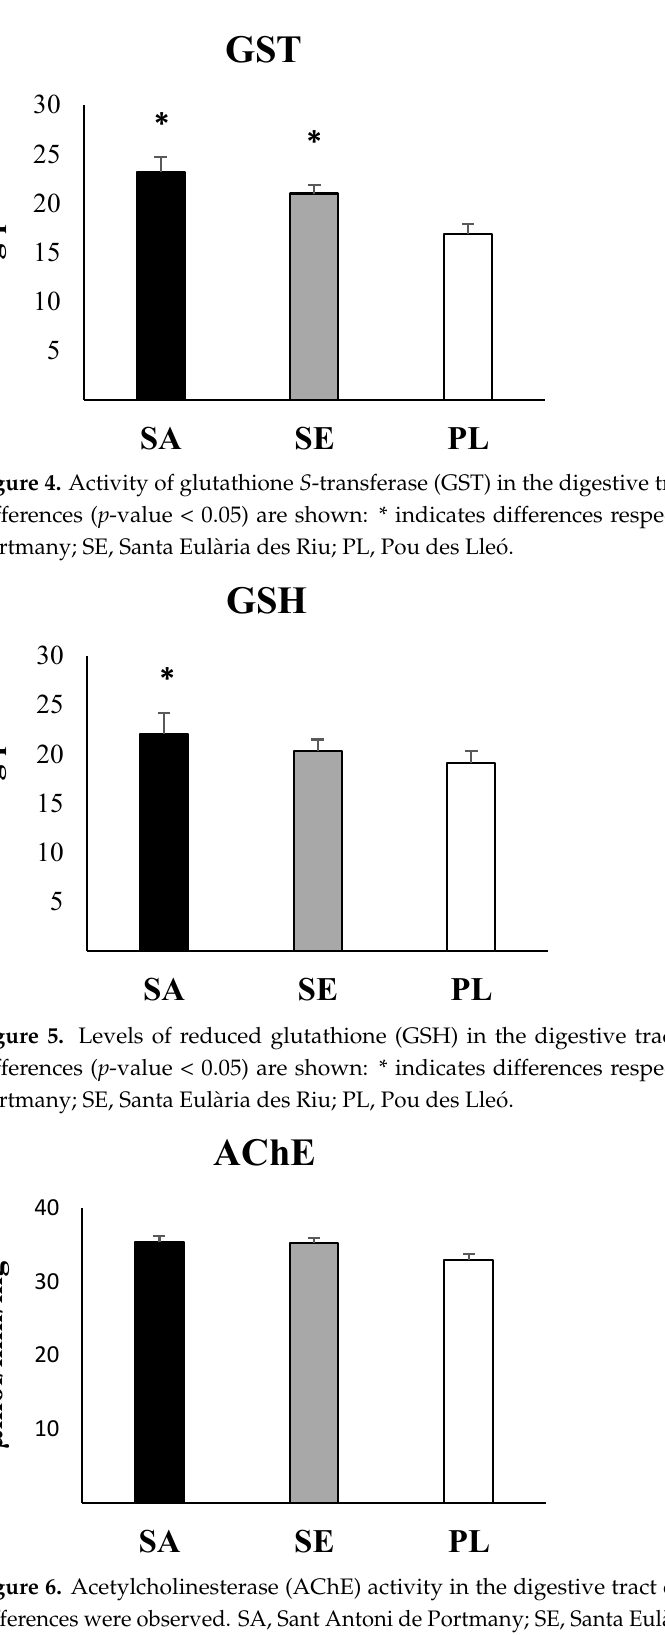
Figure 7. Malondialdehyde (MDA) levels in the digestive tract of H. tubulosa . No significant differences were observed. SA, Sant Antoni de Portmany; SE, Santa Eulària des Riu; PL, Pou des Lleó. 3. Discussion Marine pollution is a serious problem, evident even in the most pristine and isolated environments such as Antarctica or abyssal trenches [45,46]. Among these pollutants, plastics have become a global concern due to their progressive growth and potential effects on marine ecosystems. The results obtained revealed the presence of plastic elements in the sediments of the three study areas, although their number increased with the degree of anthropic influence. In addition, these results are parallel to a greater presence of MPs in the intestinal tract of H. tubulosa and a greater activation of antioxidant defense mechanisms. When analyzing the presence of MPs in the sediment of the three areas, it was observed that Sant Antoni and Santa Eulàlia, areas under anthropic pressure, have higher levels than in Pou des Lleó, an area without relevant human activity. However, the presence of MPs in the area considered clean highlights the ubiquity of plastics and their high dispersion capacity. The coastal sediments of the Mediterranean Sea are among the most important sinks for the deposition of microplastics and have an immense potential for their accumulation, due to the characteristics of the semi-enclosed sea and the high population density in coastal areas [47]. The amount of MPs in the sediments was within the range of those observed in other areas of the Spanish Mediterranean with values between 45 and 280 items/kg sediment, with an average value of 113.2 ± 88.9 MPs/kg [48]. Similar values have also been found in the sediments of